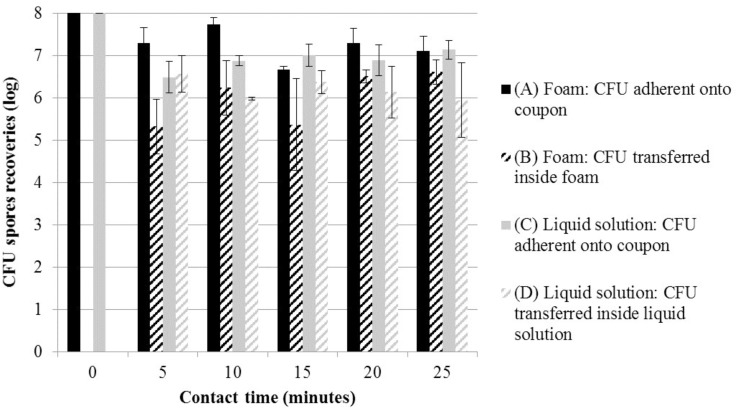
Mean log CFU (±SD) for tests without disinfectant (solution S5 in Table 1); foam form: (A) adherent on coupons () and (B) transferred inside foam (=); liquid solution: (C) adherent on coupons () and (D) transferred inside liquid solution (=), at various contact times and room temperature. CFU, colony forming units.